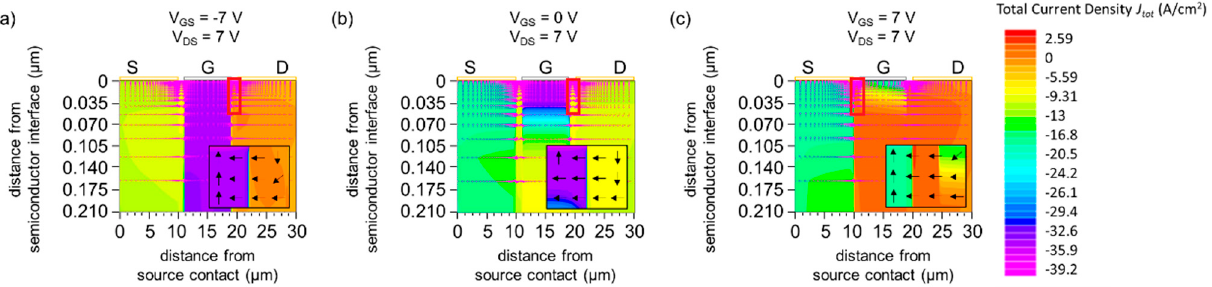
Figure 3. Simulated total current density J tot ( x , y ) for ( a ) V GS = − 7 V and V DS = 7 V ( I G -dominant regime), ( b ) V GS = 0 V and V DS = 7 V (off regime), ( c ) V GS = 7 V and V DS = 7 V (normal-operation regime). The arrows represent the simulated total current density vector. A magnified view of the semiconductor region near the gate electrode (18 µm ≤ x ≤ 20 µm for ( a , b ) and 9 µm ≤ x ≤ 11 µm for ( c )) is shown for ( a – c ). The work function of the gate is W G = 5.4 eV. The red boxes indicate the region where the total current density is high.